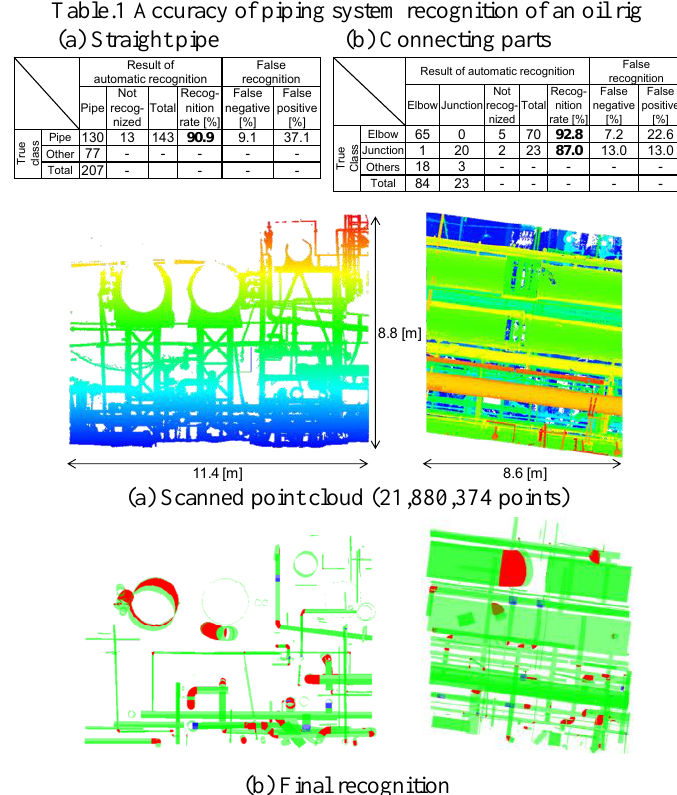
Figure.9 Recognition result of piping system of a chemical plant Table.2 Accuracy of piping system recognition